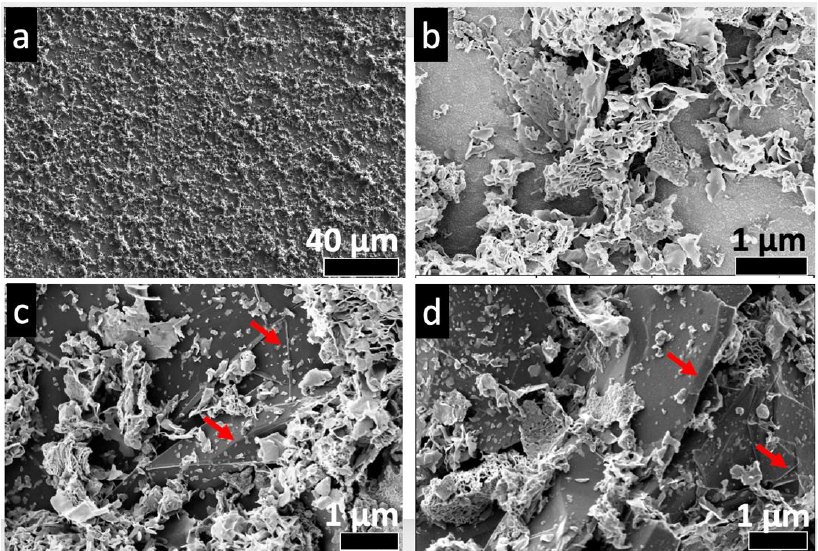
Figure 7. Low kV SEM micrographs: ( a ) typical general view for all samples; ( b ) zoom-in on neat WS 2 nanosheets; ( c ) zoom-in on WS 2 : 0.5 wt% sample; and ( d ) zoom-in on WS 2 : 1 wt% sample. Red arrows identify the graphene platelets on grapahene@WS 2 samples.